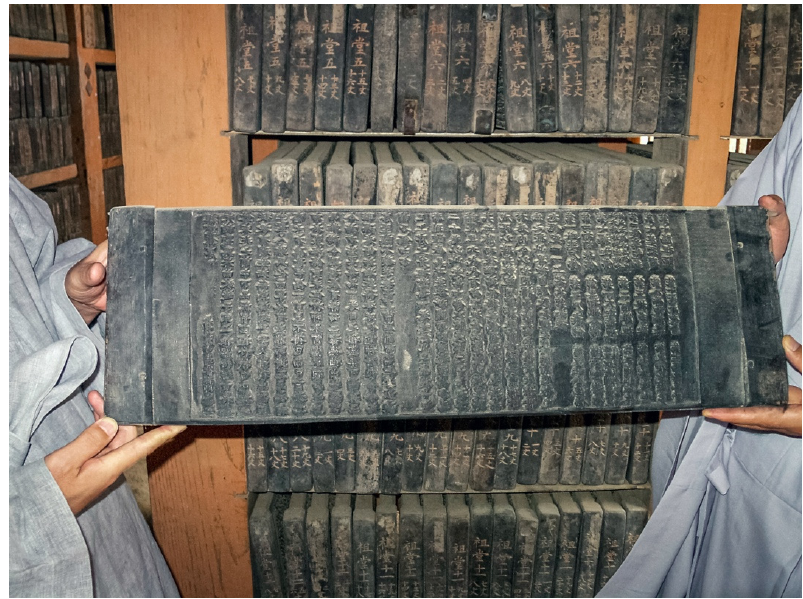
Figure 2. First zh ā ng of the ZTJ , which contains Jìngxi ū ’s preface (i.e., the first twelve lines on the left-hand side) and a part of the Goryeo preface, including the beginning of the table of contents, visible on the right-hand side (photograph by Christoph Anderl).